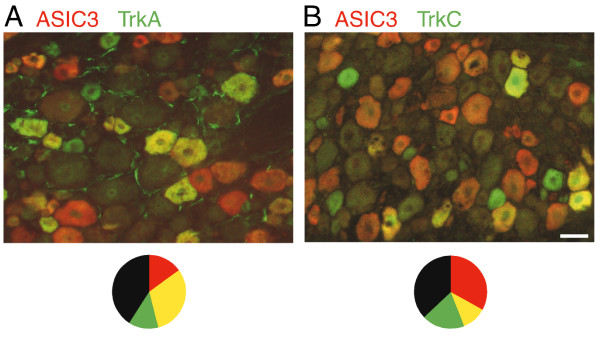
ASIC3 co-expression with TrkA and TrkC. Photomicrographs of DRG neurons labeled with antibodies to ASIC3 (red) and TrkA (A, green) or TrkC (B, green). Double-labeled cells appear yellow or orange. Circle charts show the fraction of double labeled cells (yellow), unlabeled (black), ASIC3-only (red), and TrkA or TrkC-only (green). 944 cells counted for A; 832 for B. Scale bar, 40 μm.